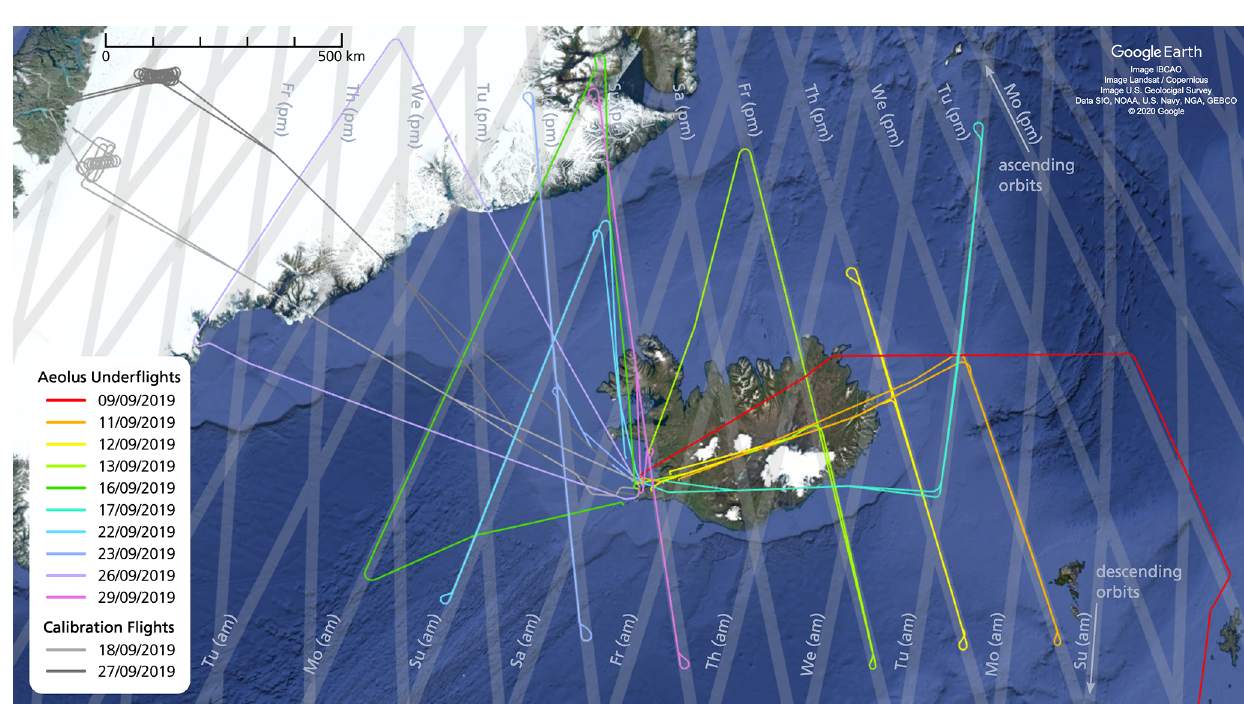
Figure 2. Flight tracks of the Falcon aircraft during the AVATARI campaign from 9 to 29 September 2019 (background image © 2020 Google). Each colour represents a single satellite underflight. The Aeolus measurement swath is shown in